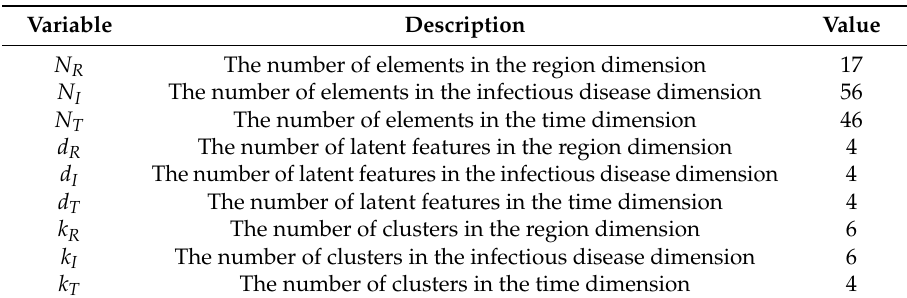
Figure 5. Graphs of the sum of the squared error (SSE) versus k for each dimension: ( a ) region, ( b ) infectious disease, and ( c ) time. Table 3. A list of hyperparameters.